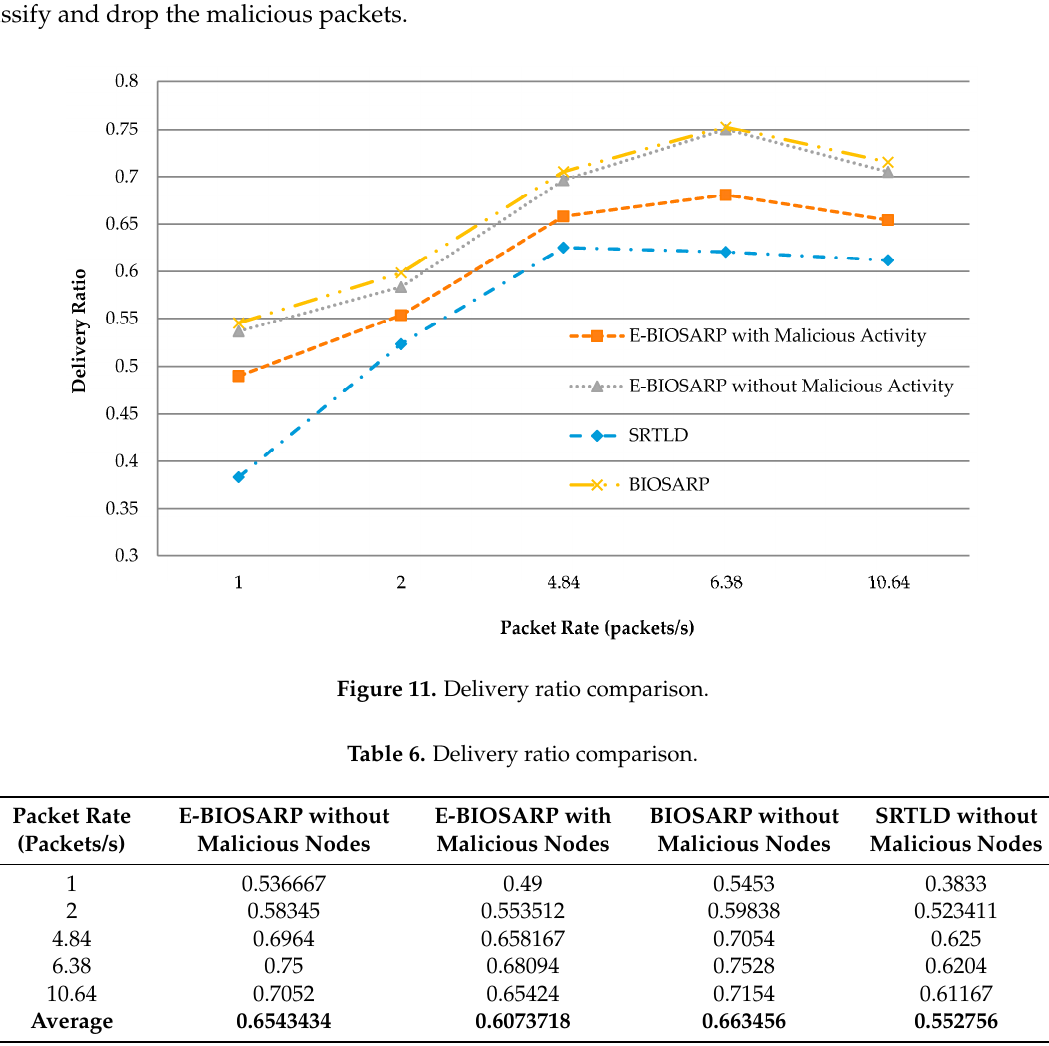
Table 6. Delivery ratio comparison.